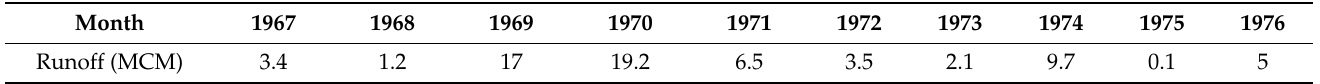
Table 1. Amount of runoff in Najran valley before the construction of the dam